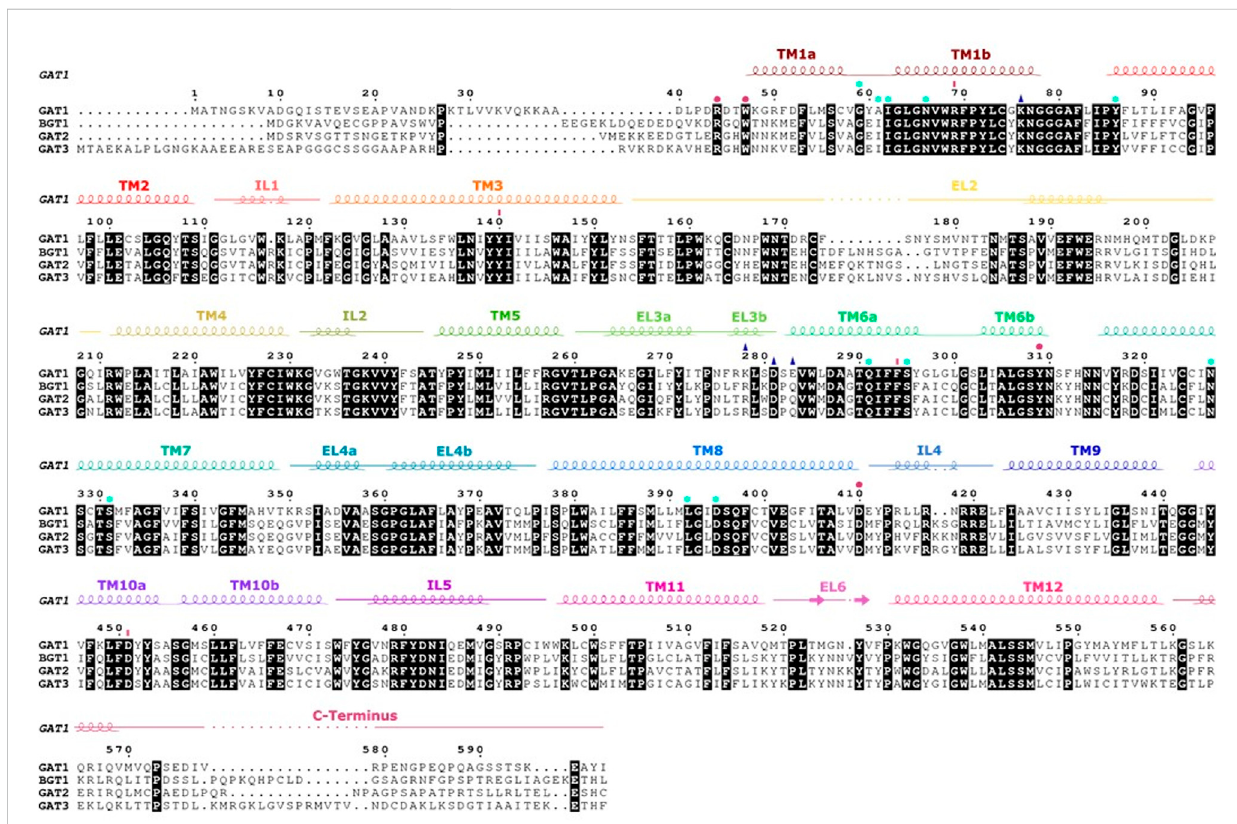
FIGURE 4 Sequence alignment and secondary structure of the four human GATs. Strictly conserved residues are highlighted in black. The α -helices and β - strands in hGAT1 are shown as coils and arrows, respectively, above the alignment as present in the structure of human GAT1 [PDB ID: 7SK2 (Motiwala etal.,2022)].Intracellularandextracellularregionsareindicatedbyastrike-throughline.Aminoacidsinvolvedintheinnerandoutergatesaresymbolized bypinkdotsandlines,residuesinteractingwithNa + andCl − arerepresentedbylightbluestars.Theaminoacidsoftheallostericsiteareshownwitha dark blue